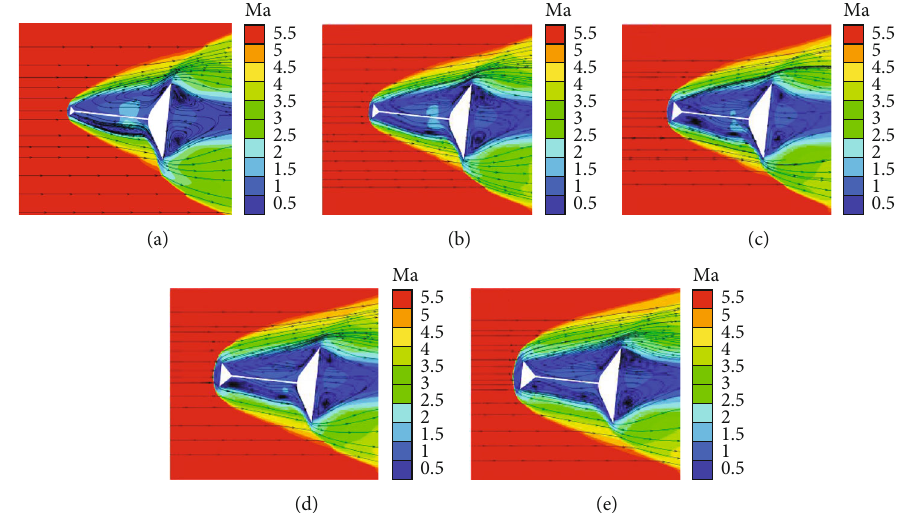
Figure 14: Mach number contours and streamline diagrams of di ff erent d / D at a pitch angle of 6.67 ° . (a) d / D = 0 : 125 . (b) d / D = 0 : 1875 . (c) d / D = 0 : 25 . (d) d / D = 0 : 3125 . (e) d / D = 0 : 375